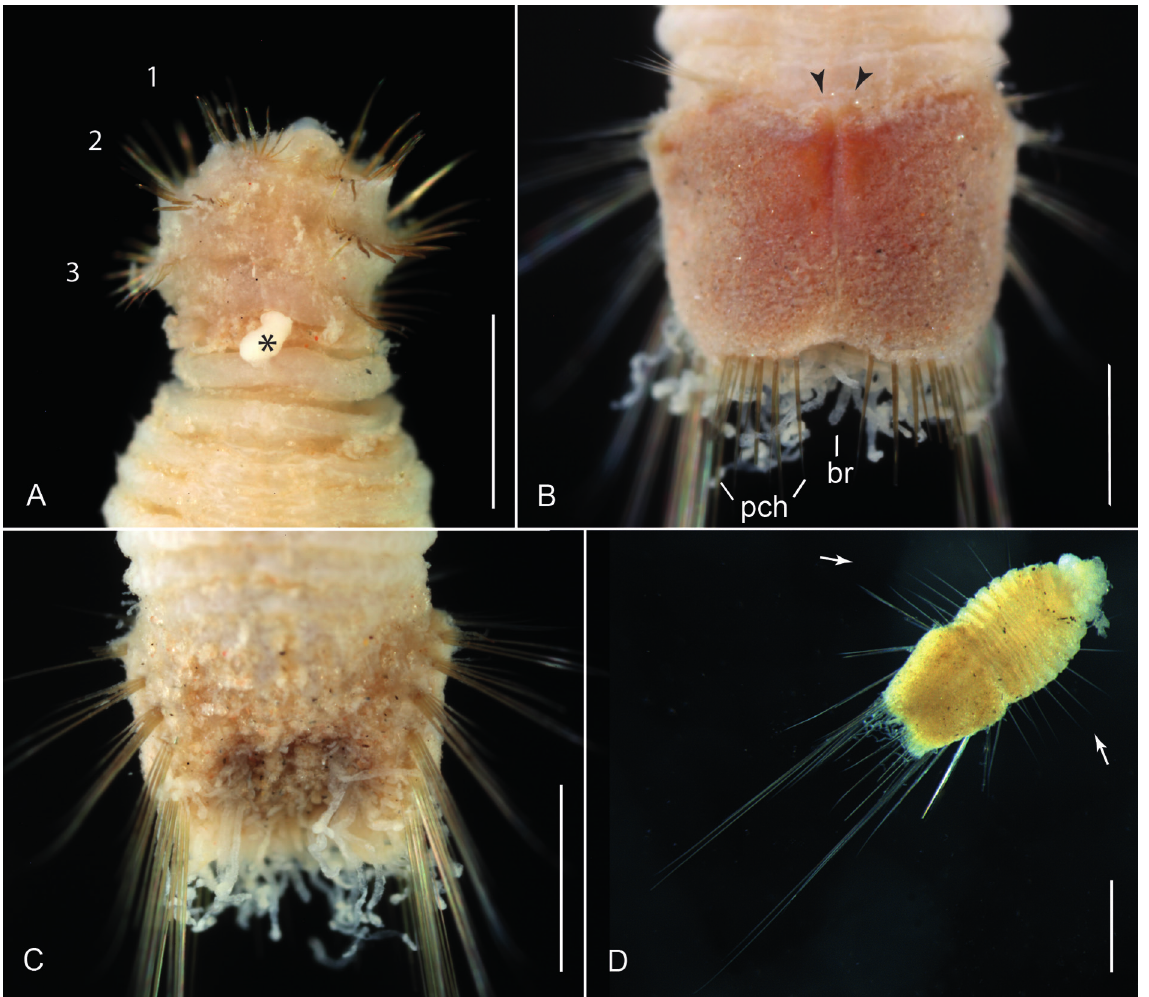
Fig. 3. Mauretanaspis longichaeta gen. et spec. nov. A–C . Holotype (MNHN-IA-TYPE 2005). A . Anterior end (introvert) with tapering hooks, ventral view. B . Ventro-caudal shield, ventral view. C . Posterior end, showing brownish branchial region, dorsal view. D . Juvenile specimen collected off Angola (MNHN-IA-PNT 120) (anterior end damaged, gonopodial lobes not developed), ventral view. Abbreviations: br = branchial filament; pch = posterior shield chaetae. Numbers 1–3 = anterior segments with hooks; * = body damaged with oesophagus protruding; arrowheads = anterior keels of shield; arrows = chaetae of pre-shield segments. Scale bars: A–C = 1 mm; D = 0.5